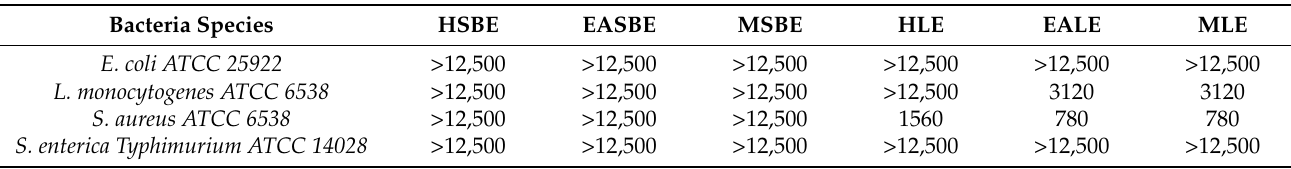
Table 1. Determination of the minimum inhibitory concentrations (MIC) of the leaf and stem bark extracts of Humiria balsamifera